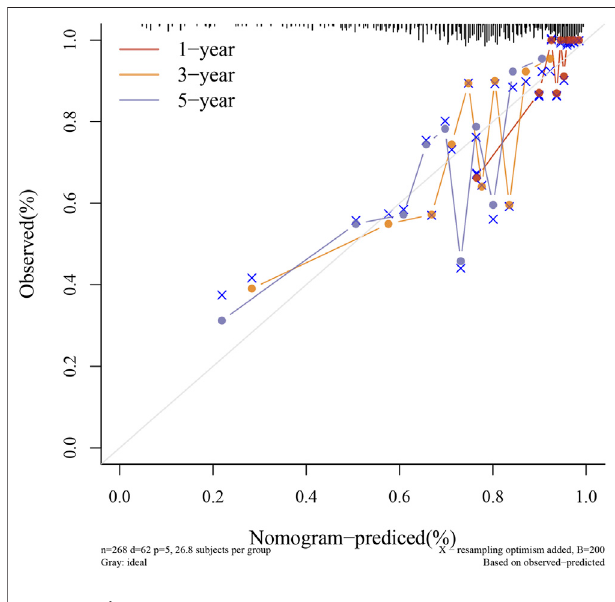
FIGURE 8 | Calibration